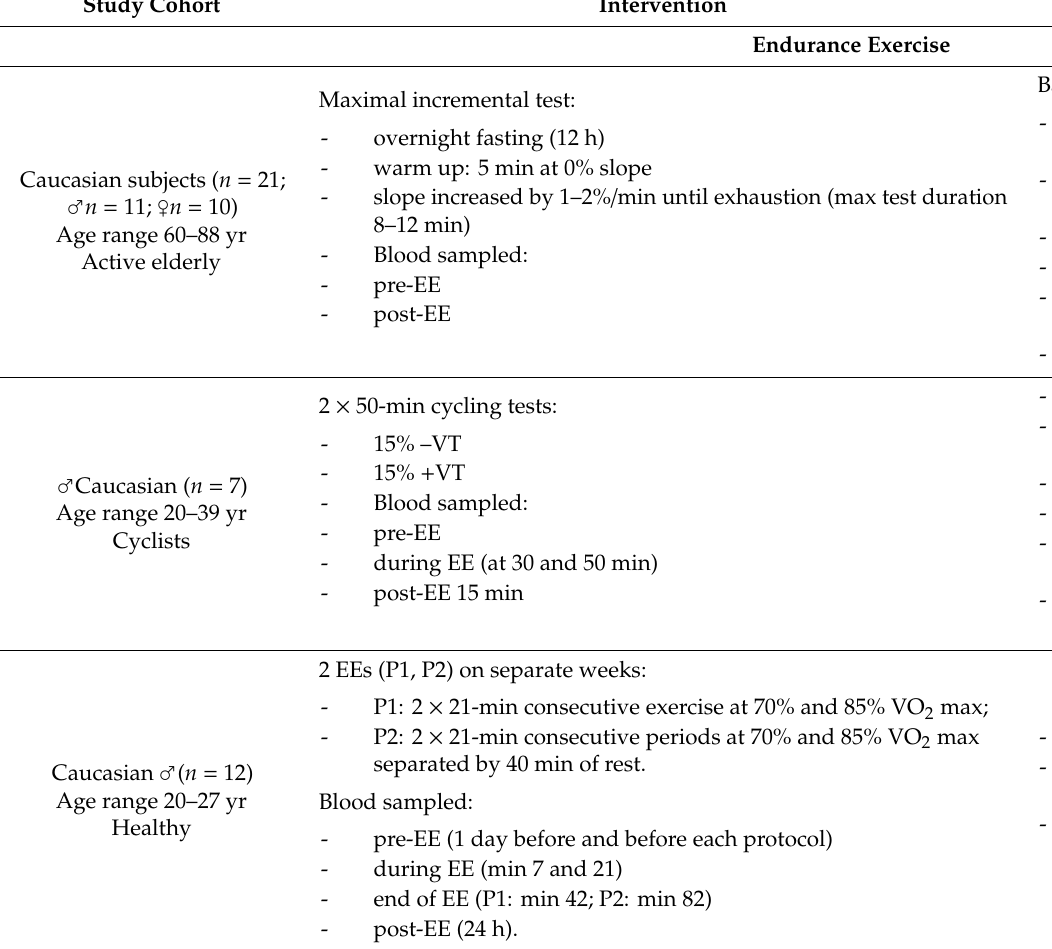
Table 2. Regulation of PTH secretion and PTH-dependent calcium-phosphate metabolism during acute exercise in humans. Study Cohort Intervention Physiological Outputs Ref. Endurance